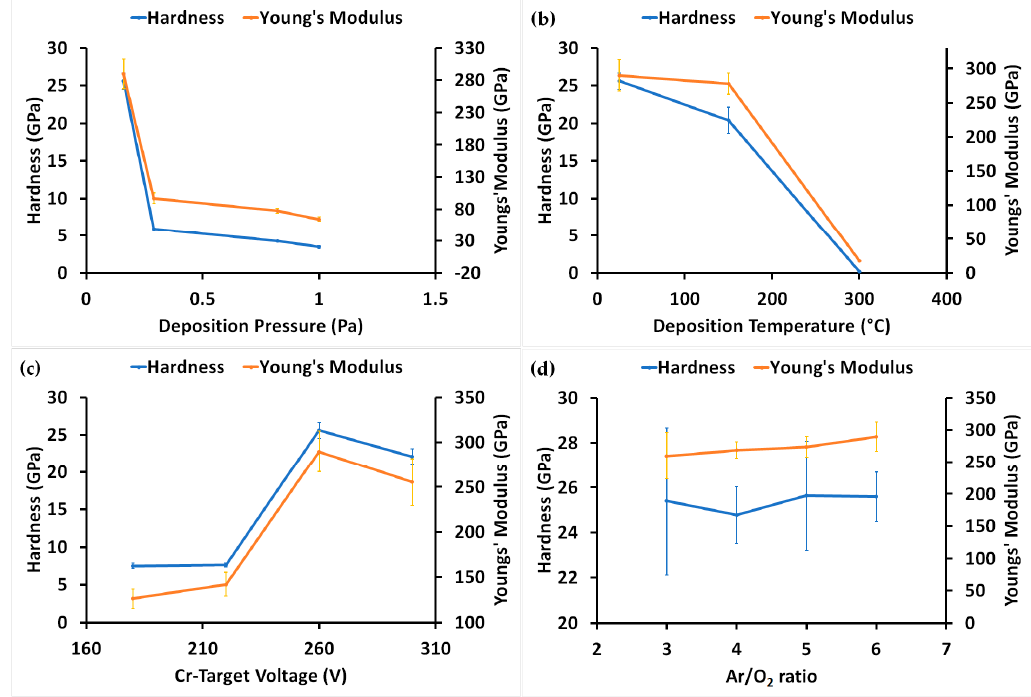
Figure 9. Effect of ( a ) deposition pressure, ( b ) deposition temperature, ( c ) Cr-target voltage, and ( d ) Ar/O 2 ratio on the hardness and Young’s modulus of the coatings. Some of Standard deviations are too small to be seen in the graphs.